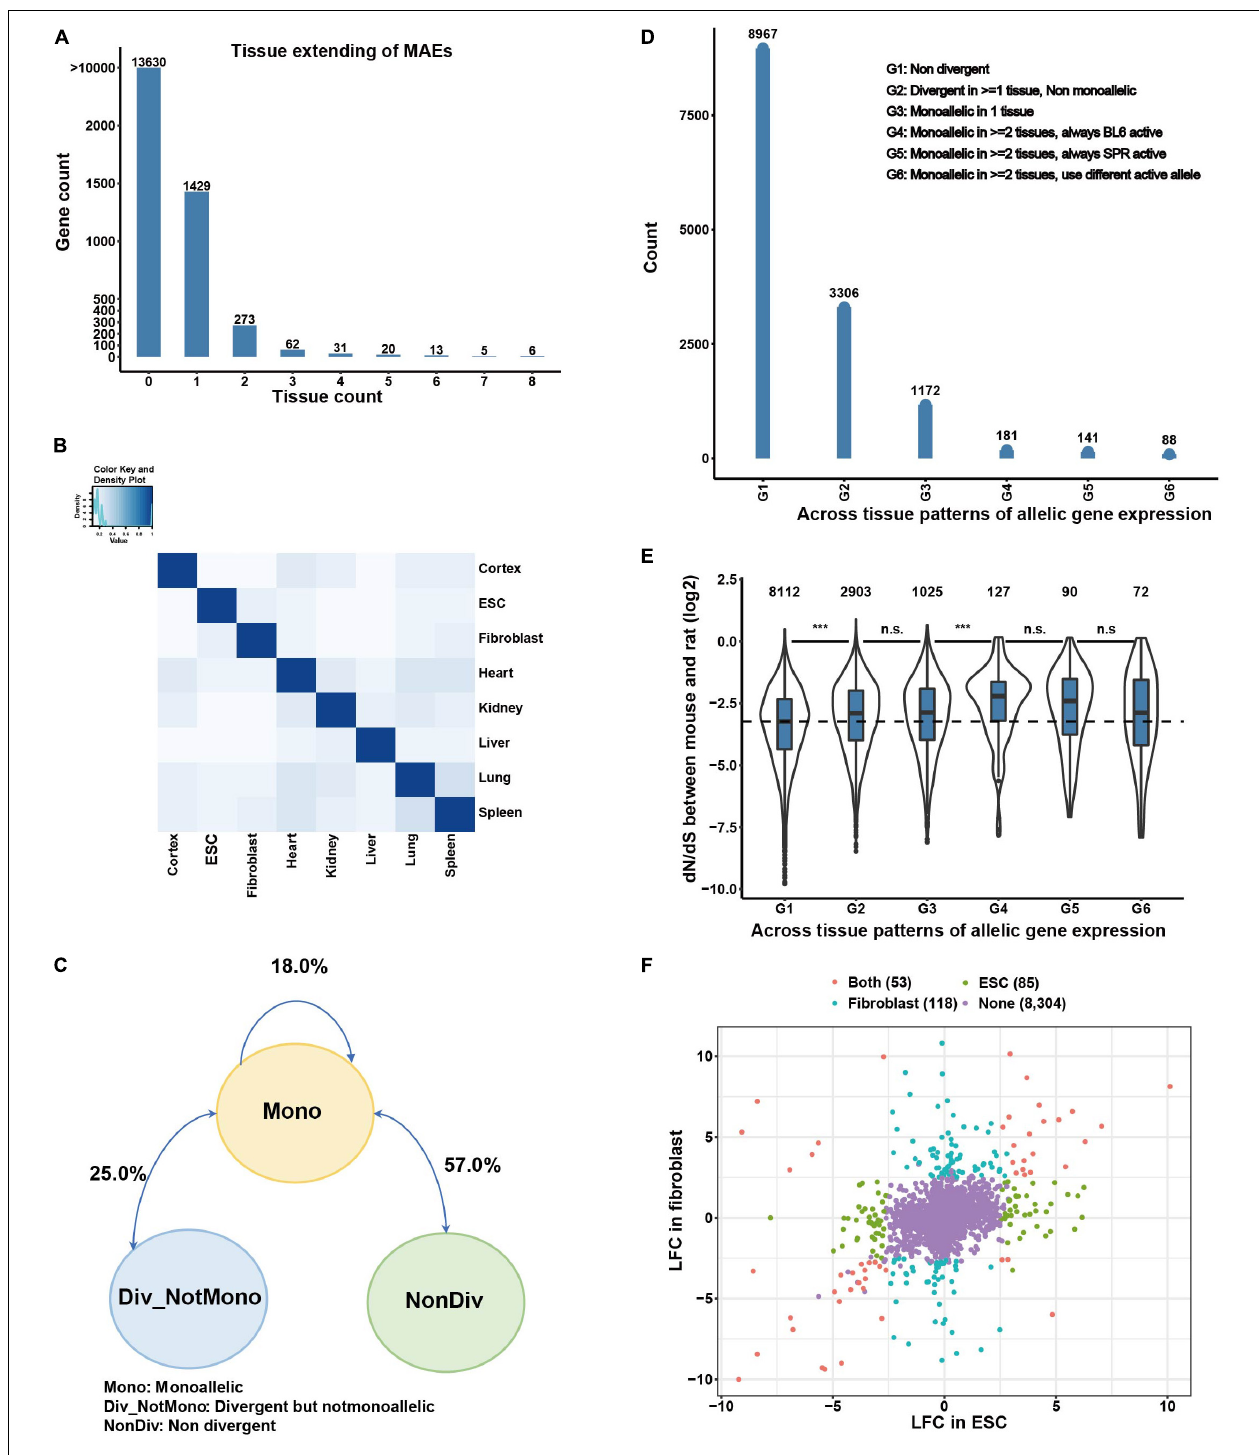
FIGURE 2 | Monoallelic gene expression is mostly tissue-dependent. (A) Tissue distribution of monoallelic expressed genes. Zero in x axis means those genes are not MAEs in any of the analyzed tissues/cell types. (B) Replication rate of MAEs between tissues. Replication rates are measured by Jaccard Index (see section “Materials and Methods”). (C) Transition between different regulatory patterns. (D) Genes are classified into six groups based on their monoallelic patterns across tissues. G1 means the genes are non-divergent across tissues; G2 means the genes are divergent in more than one tissue but not monoallelic; G3 means the genes are monoallelic in only one tissue; G4 means the genes are monoallelic in more than one tissue and always BL6 allele active; G5 means the genes are monoallelic in more than one tissue and always SPR allele active; G6 means the genes are monoallelic in more than one tissue but with different active alleles. (E) dN/dS ratios of genes in different classes. (F) Comparison of monoallelic gene expression patterns between ESCs and fibroblasts.